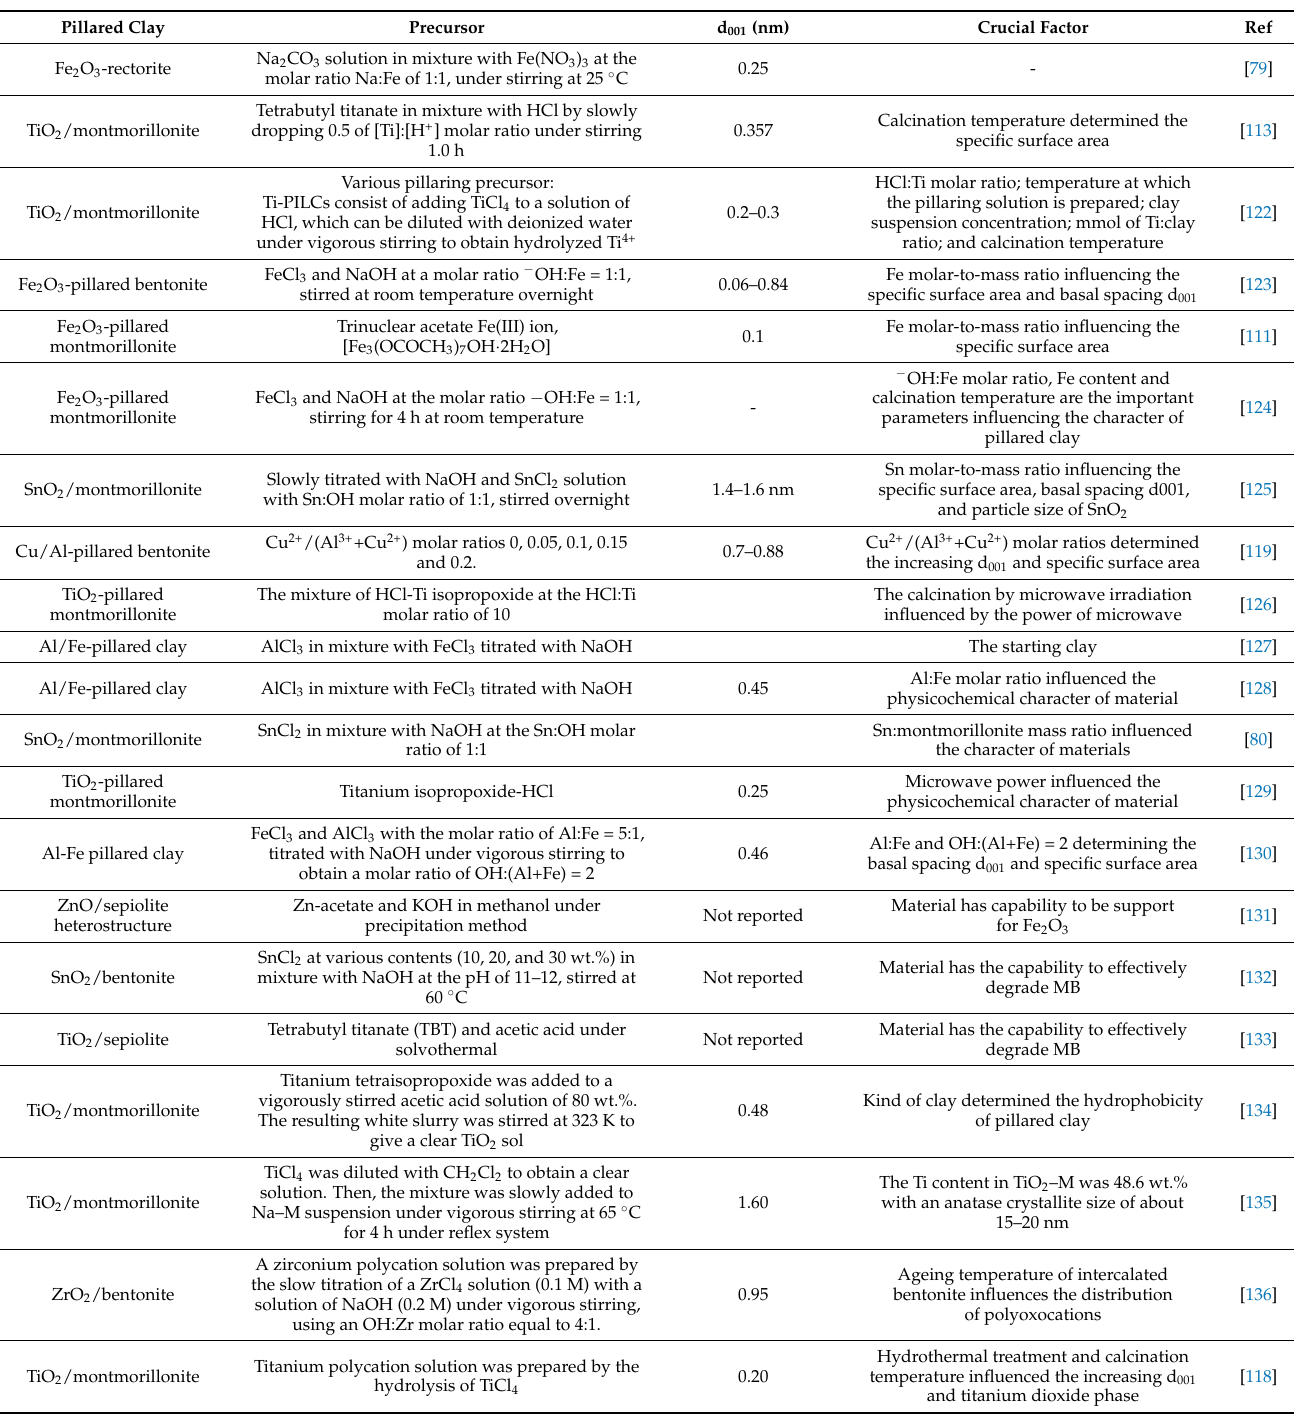
Table 2. Some pillared clays syntheses and highlighted crucial factors for the